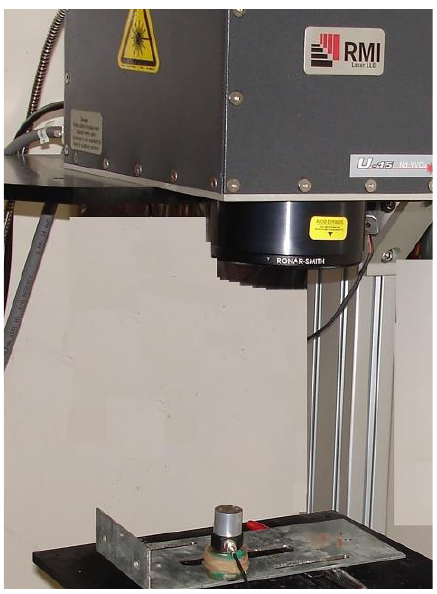
Figure 3. General view of the processing area of the U15 laser machine with a placed accelerometer.